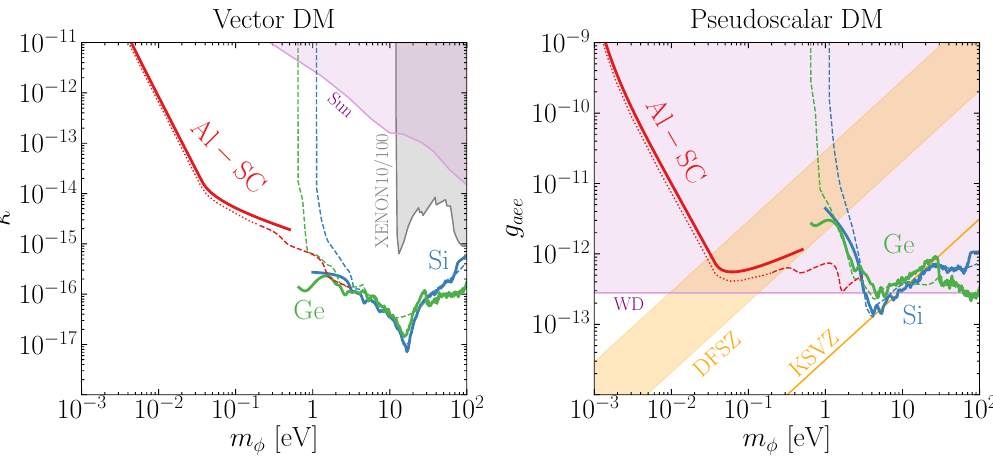
Figure 2 . Projected 95% C.L. reach (3 events with no background) with semiconductor crystal (Si, Ge) and superconductor (Al-SC) targets for the vector and pseudoscalar DM models defined in eq. (2.3), assuming 1 kg-yr exposure. We compare our theoretically calculated reach (solid) against the data-driven approach utilizing the target material’s measured conductivity/dielectric [83, 84] (dashed). For Si and Ge, the data-driven approach was taken in previous works [14, 15], with which we find good agreement. For Al-SC, our theoretical calculation reproduces the results in ref. [24] (dotted) up to the choice of overall normalization factor. Also shown are existing direct detection limits from XENON10/100 [15], stellar cooling constraints from the Sun (assuming Stückelberg mass for vector DM) [85] and white dwarfs (WD) [86], and pseudoscalar couplings corresponding to the QCD axion in KSVZ and DFSZ (for 0 . 28 ≤ tan β ≤ 140 ) models [87].